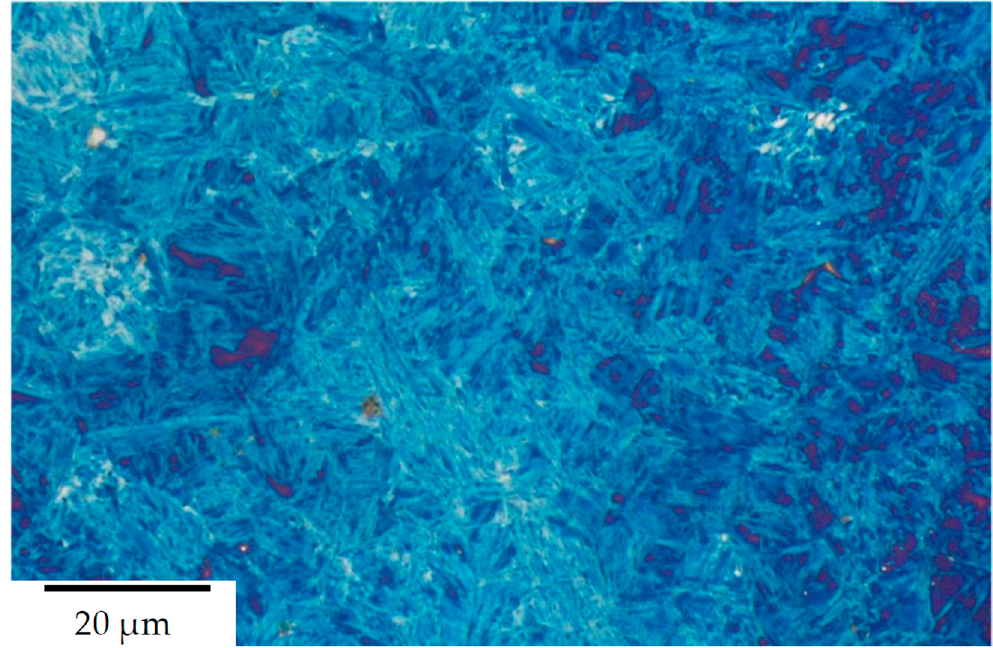
Figure 2. Light micrograph of steel A0 after heat treatment acc. to route ① . (Etched with 7% Na 2 S 2 O 5 , bainite is coloured blue, retained austenite dark/violet).